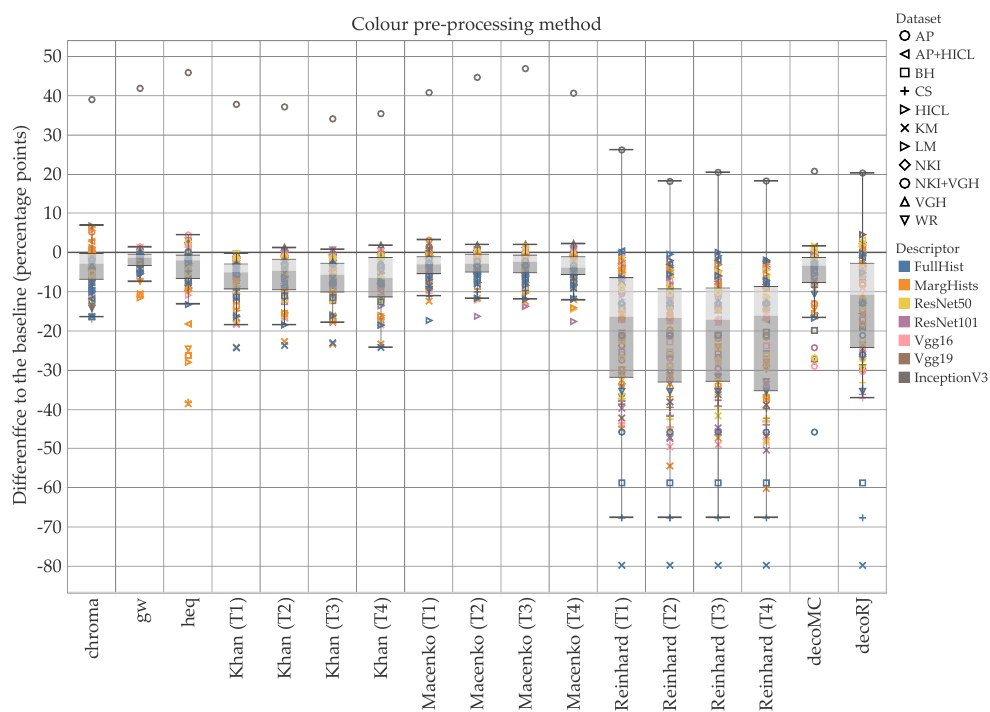
Figure 9. Difference to the baseline for each color pre-processing method (color hand-designed descriptors and convolutional networks). Color shows details about descriptor, shape about data set. The data are filtered on f = 4. The zero line represents the condition where no color pre-processing was applied. It should be noticed the considerable decrease of accuracy of Reinhard’s methodology, irrespective of the target image. This is due to the reliance of the methodology on color. On the other hand, results for T1 were slightly higher than T2-T4 for both Reinhard and Macencko. This is surprising as T1 is not histological and the colors are considerably different from the images to normalize. Note the presence of outliers both above and below the zero line, respectively InceptionV3/AP and FullHist/KM.